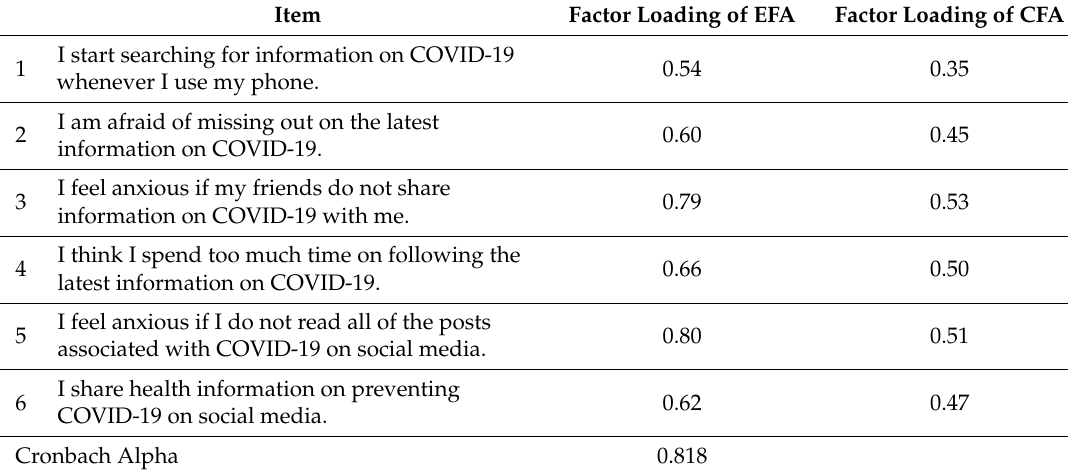
Table 1. Factor loadings of the COVID-19 Information Fear of missing out scale (CIFS). Item Factor Loading of EFA Factor Loading of CFA